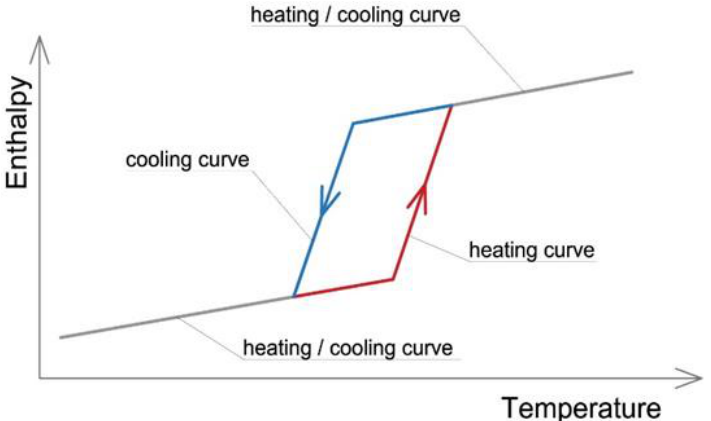
Figure 4. Phase change hysteresis process represented as a function of temperature [26].